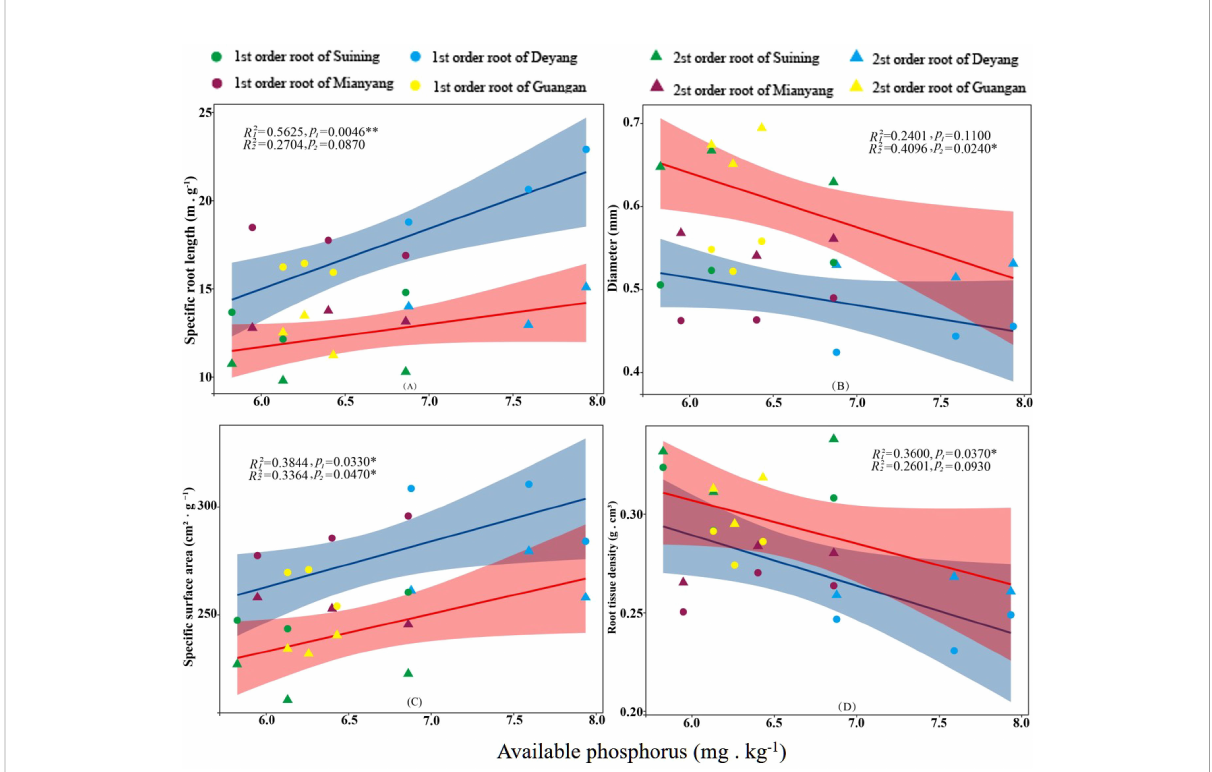
FIGURE 5 Effects of soil available phosphorus on speci fi c root length, root diameter, speci fi c root surface area, and root tissue density at four research sites. R 12 and R 22 represent coef fi cients of determination for regressions of fi rst- and second-order fi ne roots *and **indicate signi fi cance at p < 0.05 and p < 0.01, respectively. p 1 and p 2 are p- values indicating signi fi cance of regressions with fi rst- and second-order fi ne roots, respectively. The shaded part is the con fi dence interval of the fi tting line, regimes (n = 3 per